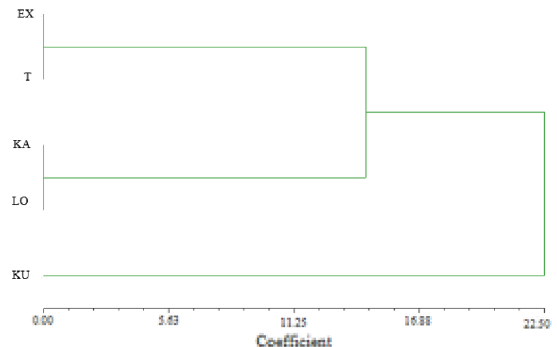
Fig. 8 Dendrogram of the 5 giant plantain populations studied generated by UPGMA cluster analysis of the similarity matrix obtained using Nei’s genetic distance based on ISSR data (Nei,